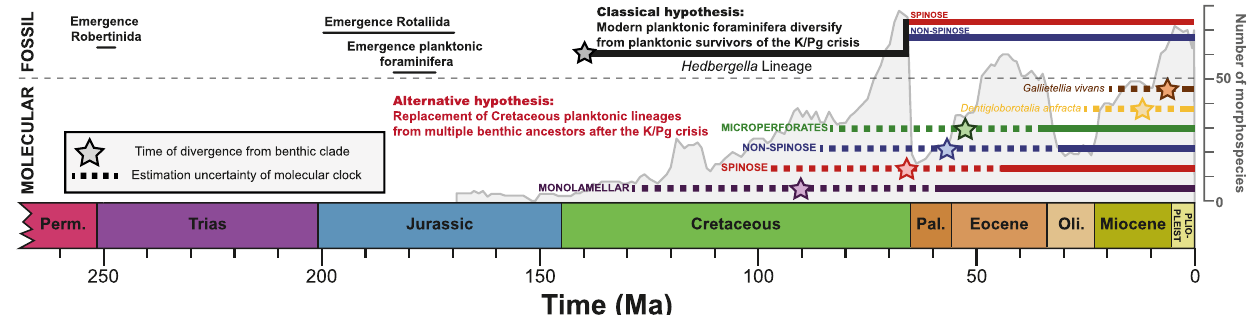
Fig. 5 | Emergence of modern planktonic foraminifera. The emergence of the modern clades of planktonic foraminifera in relation to the evolution of their diversity through the Mesozoic and Cenozoic following the classical hypothesis basedonfossilrecorddataandouralternativehypothesisbasedonmoleculardata. The gray curve represents the number of planktonic species observed in the fossil record (from ref. 8). The time of divergence between the extant clades and their